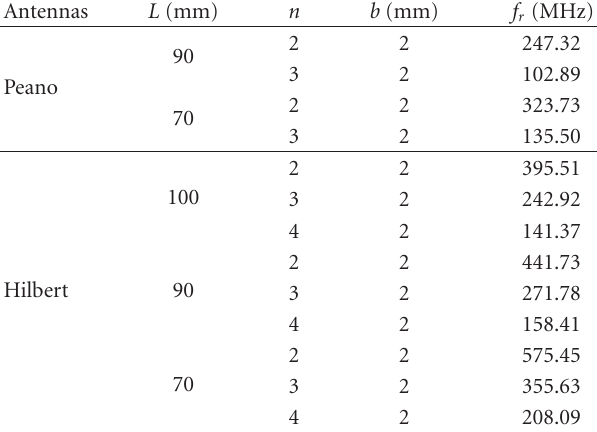
Table 1: Resonant frequencies of Peano and Hilbert fractal anten- nas with di ff erent geometry parameters.